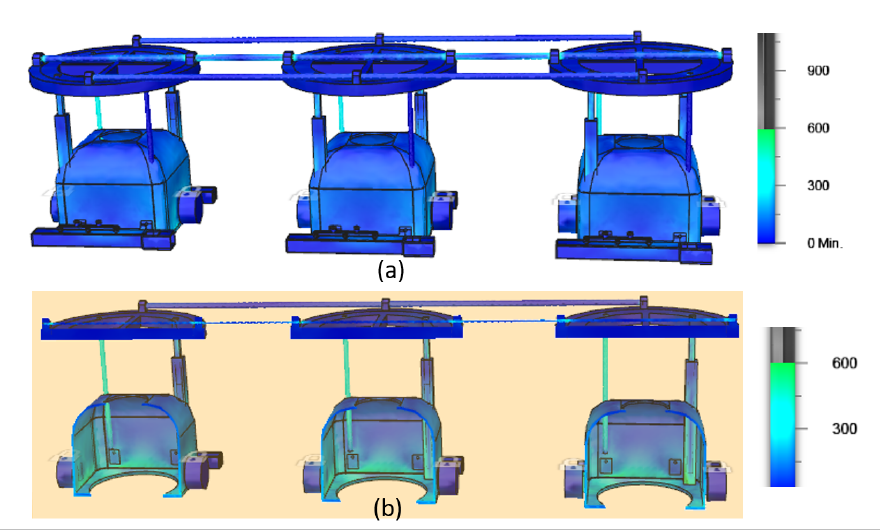
Figure 10. Stress distribution (MPa) in the Mantis-mini platform ( a ) full view and ( b ) sectional